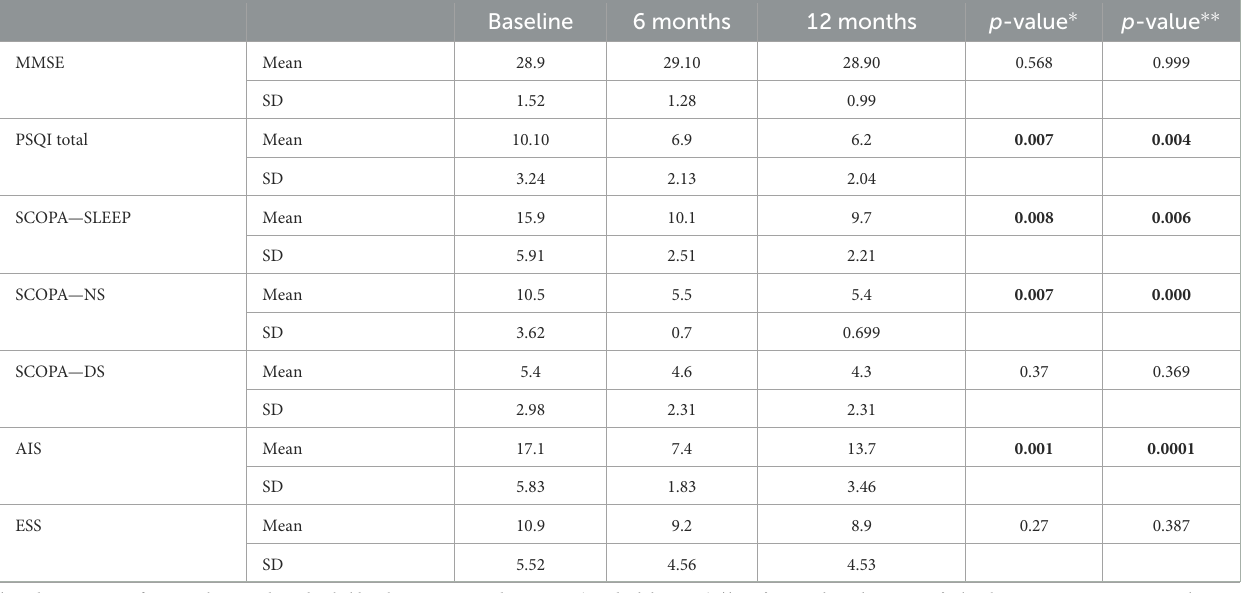
TABLE 1 Assessment of people with Parkinson’s disease at LCIG infusion initiation (baseline) and after 6 and 12 months of LCIG infusion. Baseline